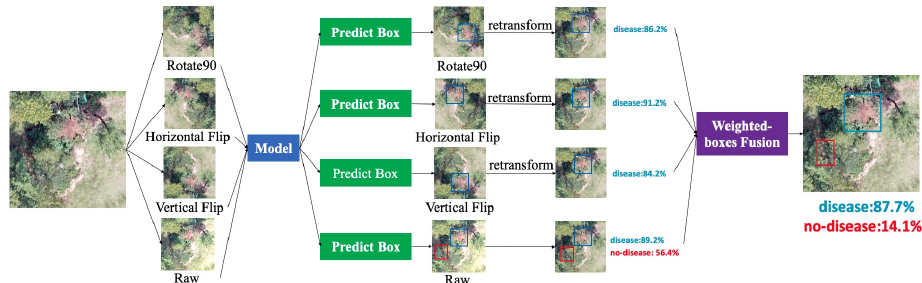
Figure 4. Test time augmentation applied in trained model. The bounding box prediction re- sults are fused through weighted boxes fusion to highlight the important region and suppress the false